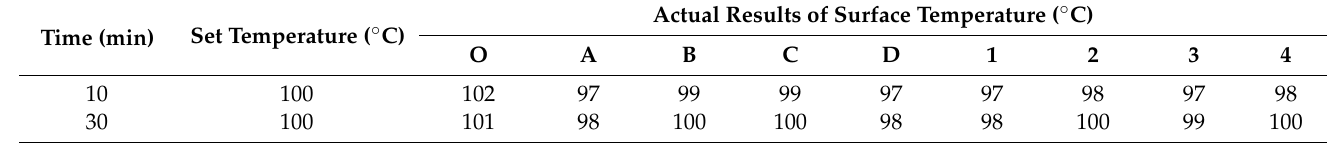
Table 3. The results of the temperature